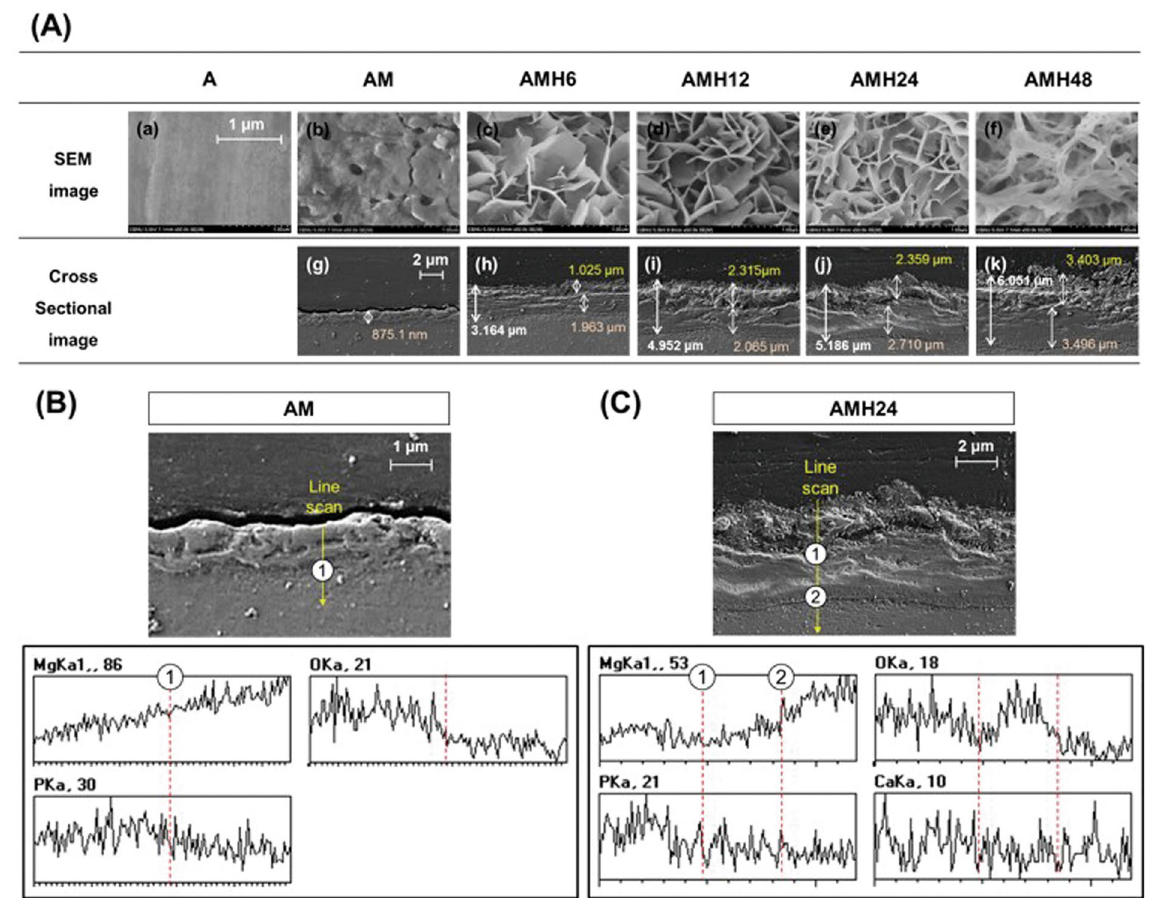
Figure 1. ( A ) FE-SEM images of the surface (a–f) and cross section (g–k) of specimens after A, AM, AMH6, AMH12, AMH24 and AMH48 treatments; EDS-line analysis on the cross section after ( B ) MAO coating and ( C ) MAO coating + hydrothermal